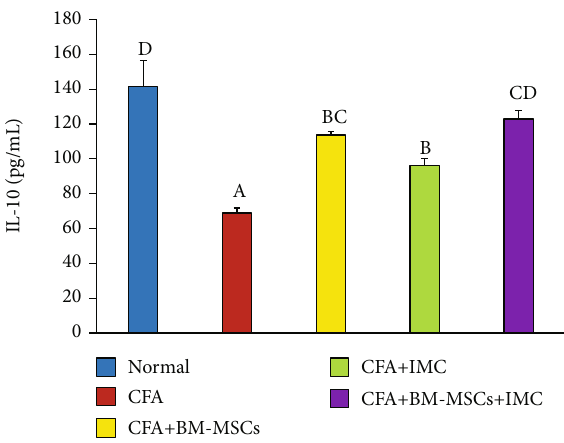
Figure 4: E ff ect of BM-MSCs and/or IMC on IL-10 concentration in CFA-induced rats. Means, which have di ff erent symbols, A, B, C, and D, are signi fi cantly di ff erent at p < 0 : 05 .